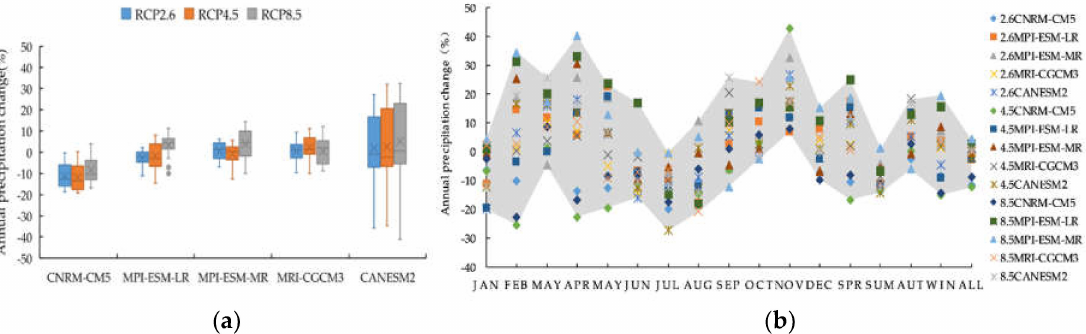
Figure 4. Multi-model projected changes in mean annual precipitation ( a ) in different Representative Concentration Pathway (RCP) scenarios and ( b ) at different time scales in the Heihe River